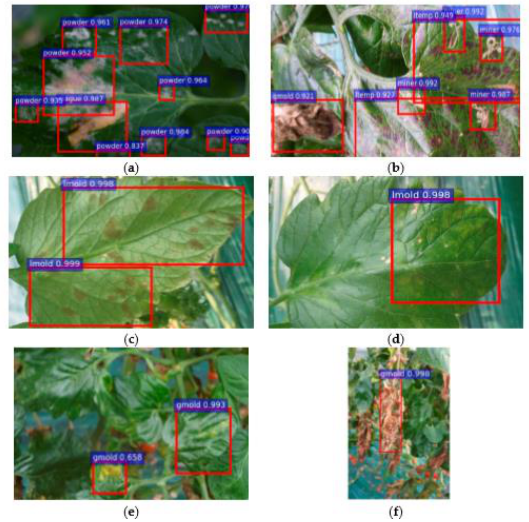
Figure 7. Bounding box indicates the type of diseases along with the probability of their occurrence [68].